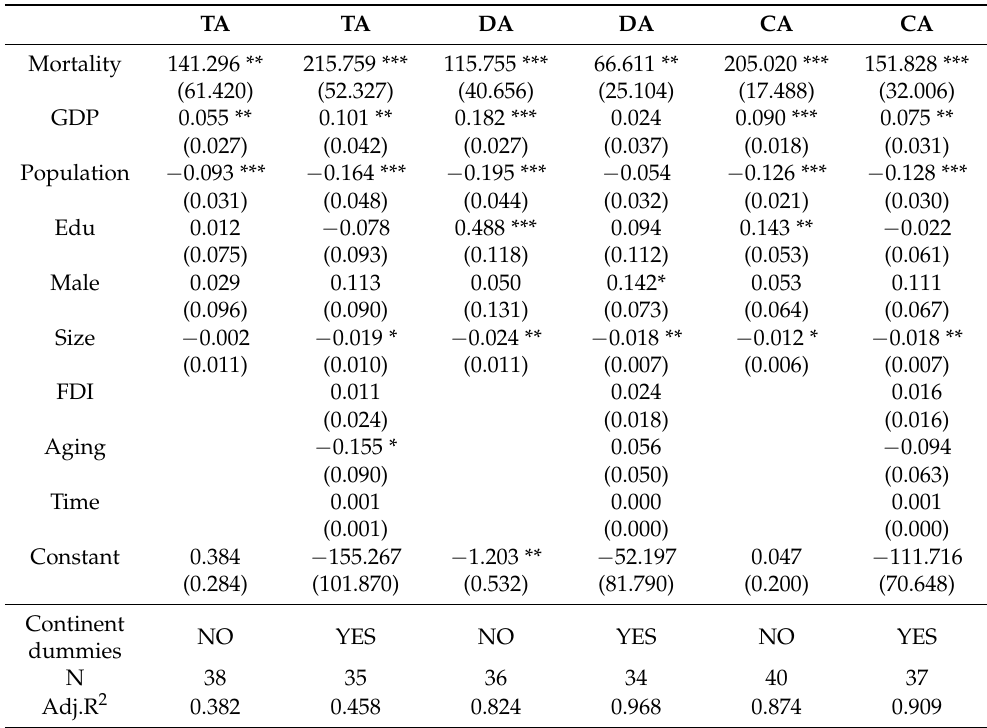
Table 3. The associations of the mortality rate and different sorts of appliances that were applied in distance education by using the robust OLS regression.